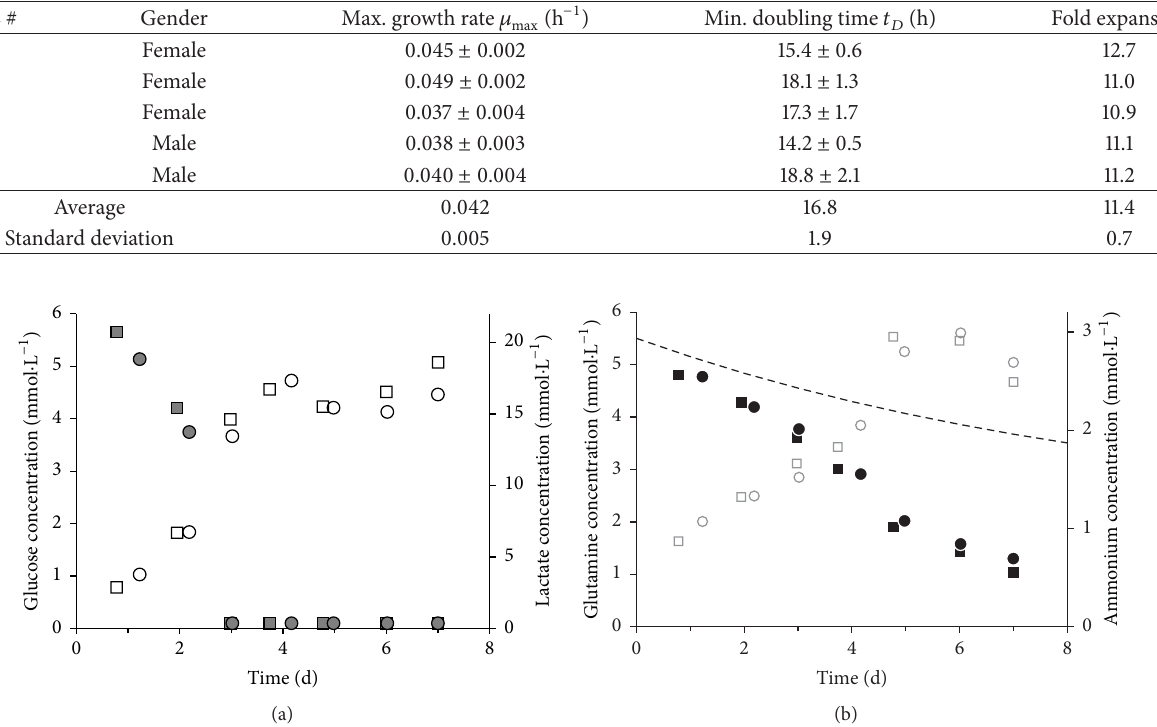
Figure 2: Metabolite profile of hUC MSCs from two different donors (HUC #255, female: squares, HUC #256, male: circles) in static 12-well cultureplatein1mLDMEMLGmediumwithseedingdensityof8000 cells ⋅ cm −2 .(a)Greyfull—glucose,white—lactate;(b)black—glutamine, grey empty—ammonium; dotted line: glutamine thermal decay.